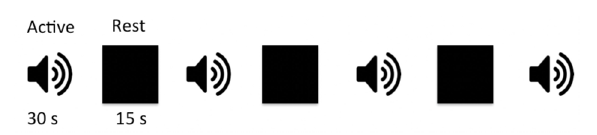
FIGURE 1 | Schematic block diagram of the auditory paradigm. The auditory task consisted of four active sound blocks interspersed with three 15-s rest blocks. Each sound block was 30 s long containing 10, 2,000 ms long sound pairs with 1,000 ms between the two sound pairs to allow for subject response. There were a total of 40 randomly selected sound pairs, from a list of 72 wave forms, presented in each